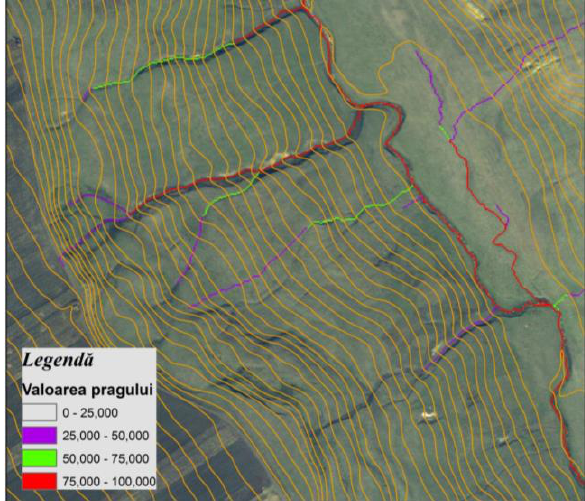
Figure 4. Accumulation raster simbolized upon different treshhold values for